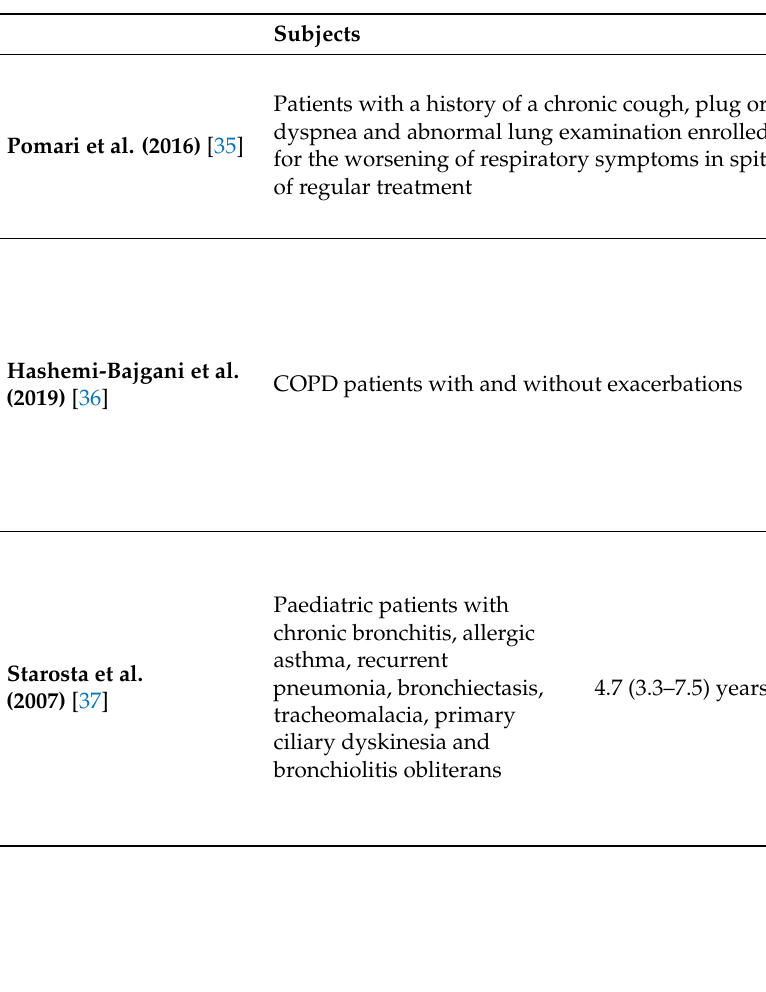
Table 2. Summary of the studies investigating pepsin levels in biological fluids retrieved from adult and paediatric subjects and the relationship between pepsin and COPD and chronic bronchitis